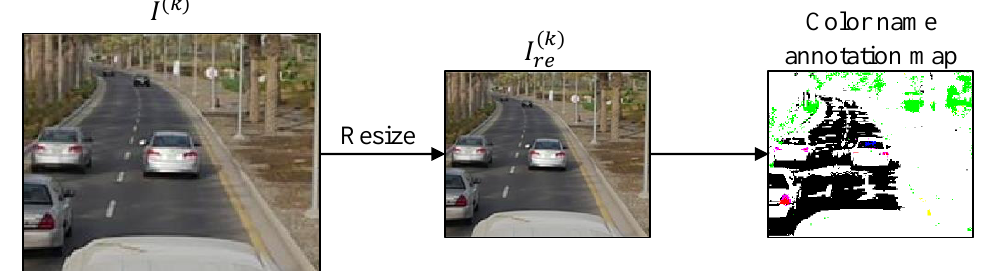
Figure 4. Pixel-wise color name